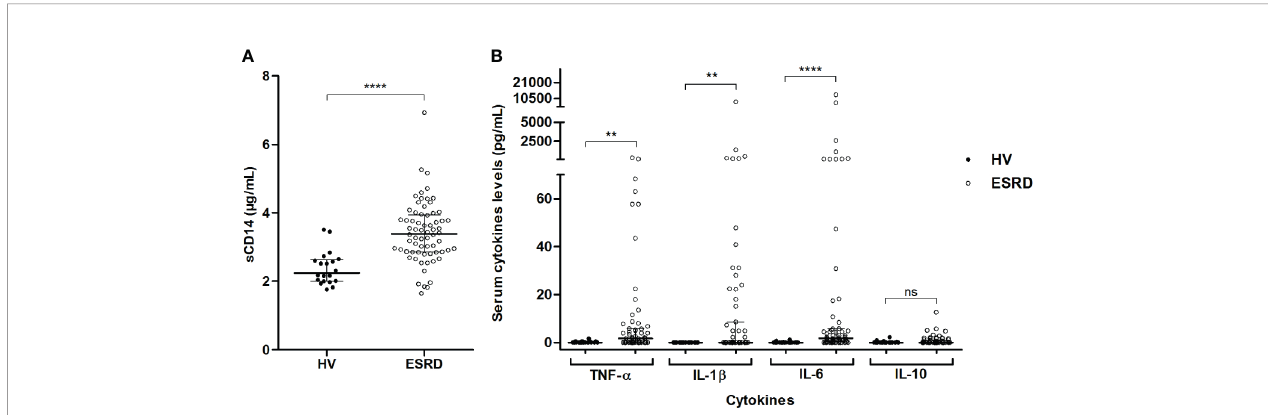
( Supplementary Tables S4, S5 ). Sera from HV (n=5) ( Supplementary Table S6 ), decomplemented sera autologous to monocytes (AS, n=3), autologous sera spiked with LPS from E.